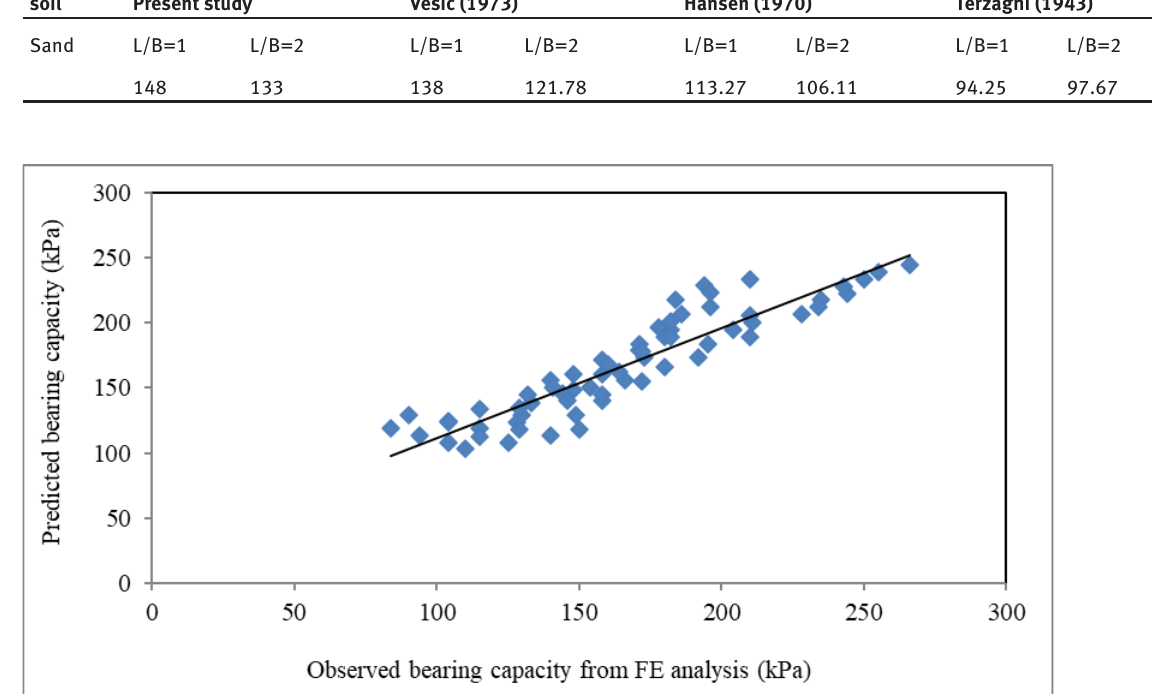
Table 9: Comparison of observed bearing capacity values with Vesic (1973), Hansen (1970), and Terzaghi (1943) calculations. Type of Bearing capacity (kPa) soil